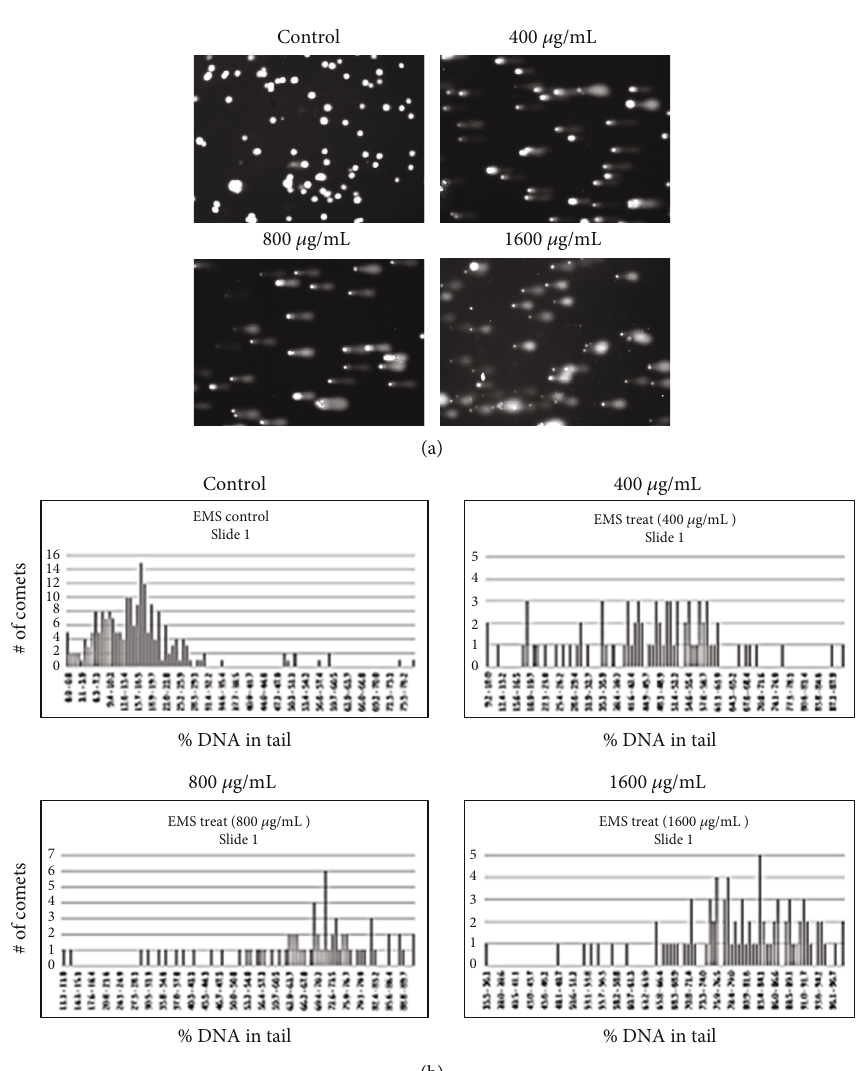
Figure 1: Comet assay measurement of DNA damage. (a) Typical comet assay images of cells after treatment with increasing concentrations of EMS. (b) From multiple images at each treatment level, the % DNA in tail was determined for individual comets and plotted as